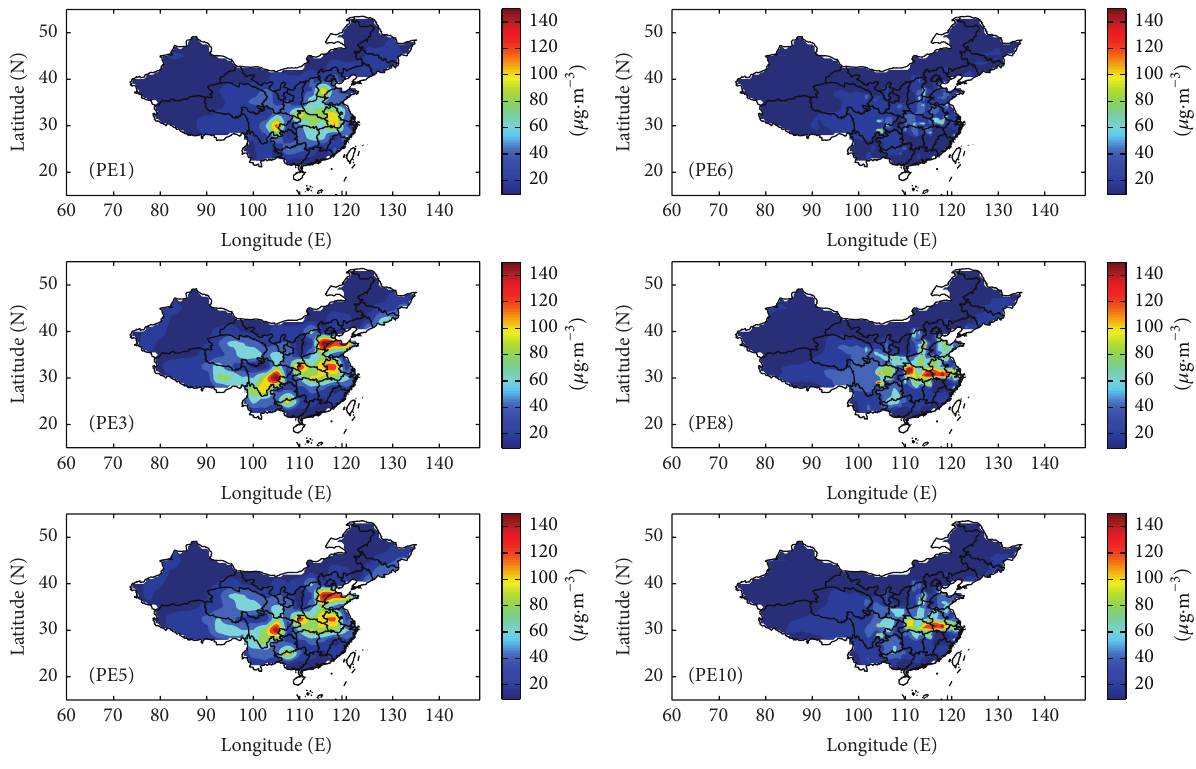
Figure 6: The IC obtained in